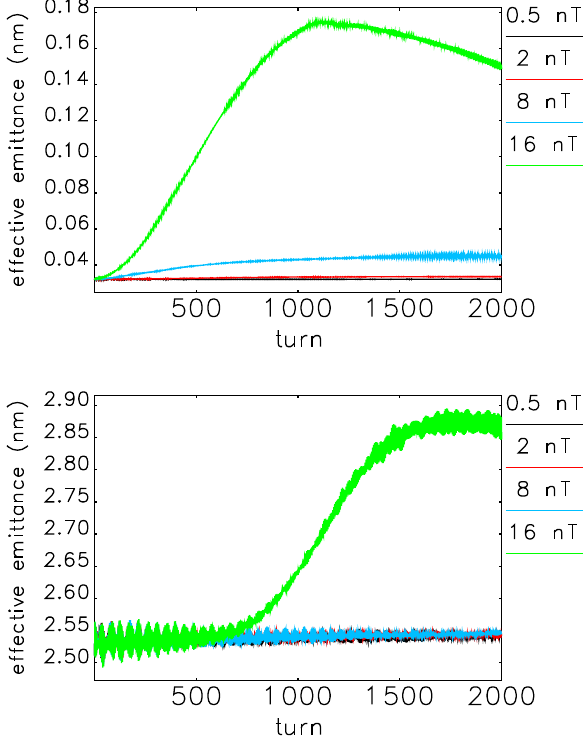
FIG. 13. Horizontal instability amplitude (top) and rms beam size (bottom), for different pressure values.